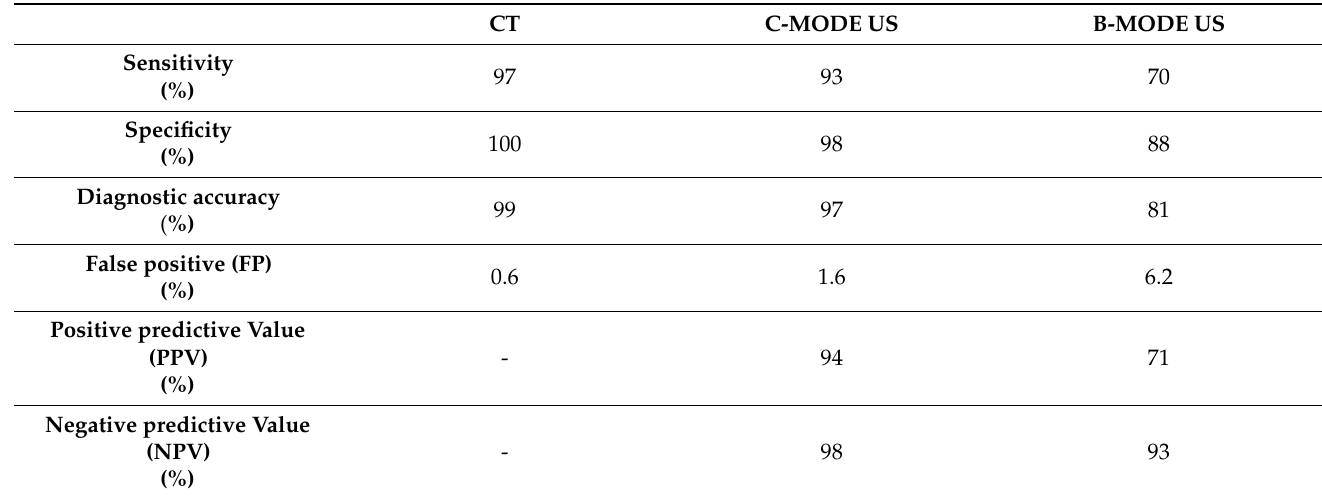
Table 2. Statistical analysis of